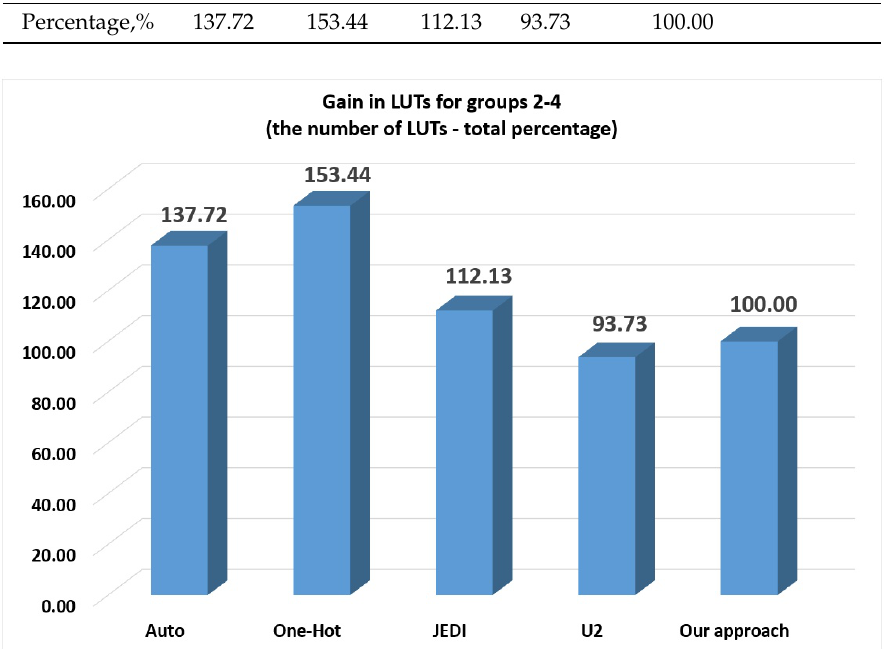
Figure 13. Gain in LUTs for groups 2–4 (LUT count—total